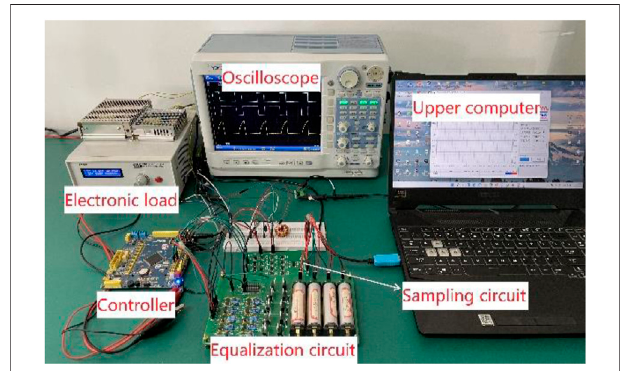
FIGURE 11 | Balancing experimental platform.